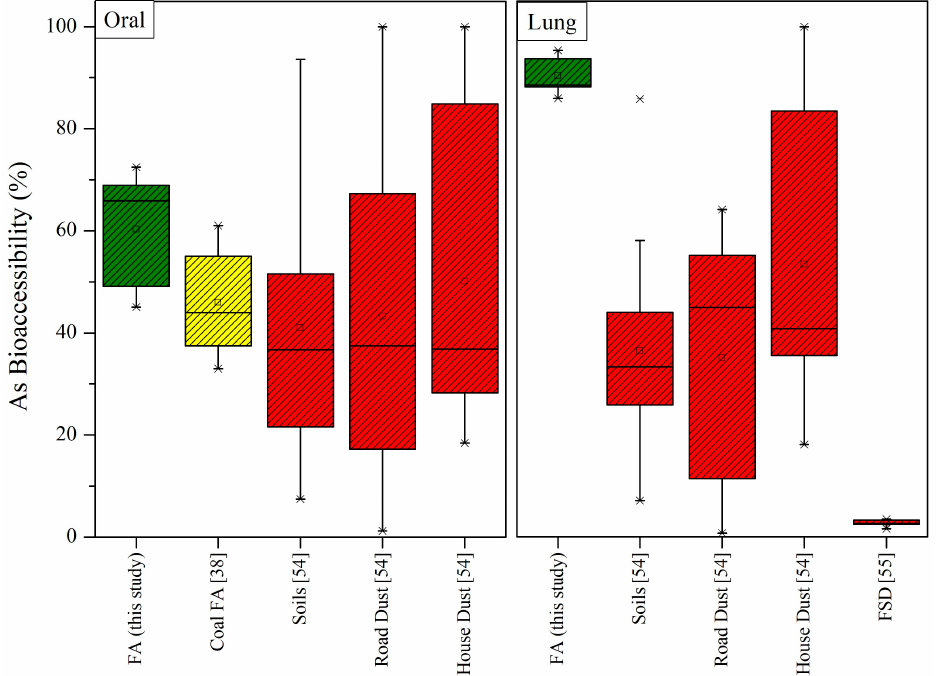
Figure 7. Comparison of As bioaccessible fractions (%) between LFA and other environmental materials. Data for other coal FAs are from Jin et al. [38], for soil, road dust, and house dust are from Kelepertzis et al. [54], and those for fine surface dust (FSD) are from Morais et al. [55]. The box is determined by the 25 th and 75 th percentiles. The whiskers ( − ) are determined by the 5 th and 95 th percentiles. Additionally, the minimum (*), median (line), mean ( □ ) and maximum (*) values are presented. Green boxes: this study; Yellow boxes: other FAs; Red boxes: other materials.